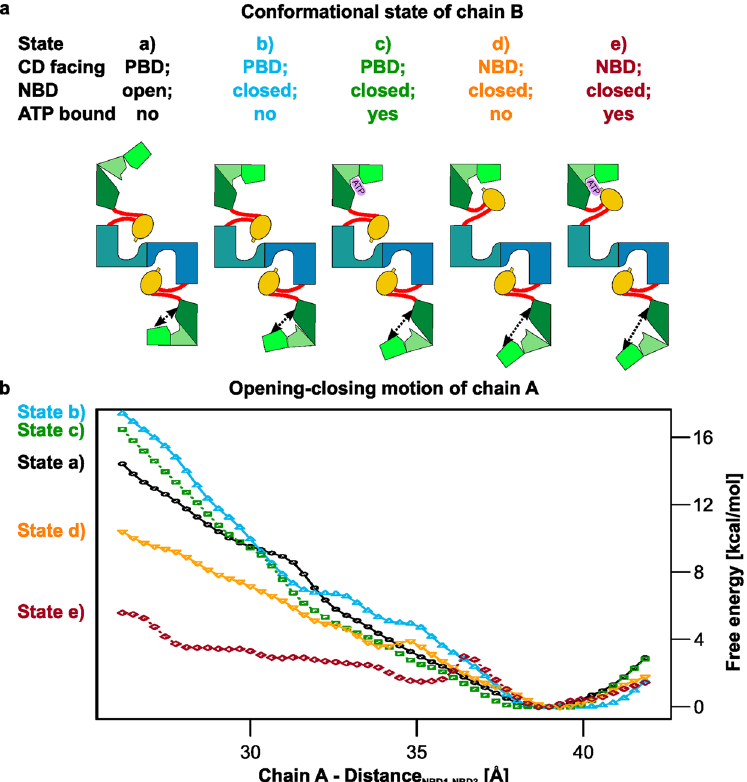
Figure 3. PMF of the opening-closing motion of chain A for different states of chain B. ( a ) Schematic representation of simulated systems and ( b ) PMF of the opening-closing motion of the NBD of chain A, with chain B having the CD facing the PBD with the NBD in the open, unbound conformation (a, black circle), closed, unbound conformation (b, blue triangle pointing upwards), and closed, ATP-bound conformation (c, green square), as well as the CD facing the NBD with the NBD in the closed, unbound conformation (d, orange triangle pointing downwards) and closed, ATP-bound conformation (e, red diamond). The distance NBD1-NBD3 between Ser215 C α – Glu272 C α was used as a reaction coordinate (depicted as black arrows in panel a). The standard deviation for all data points is < 0.02 kcal mol − 1 computed by a bootstrapping procedure (see Methods